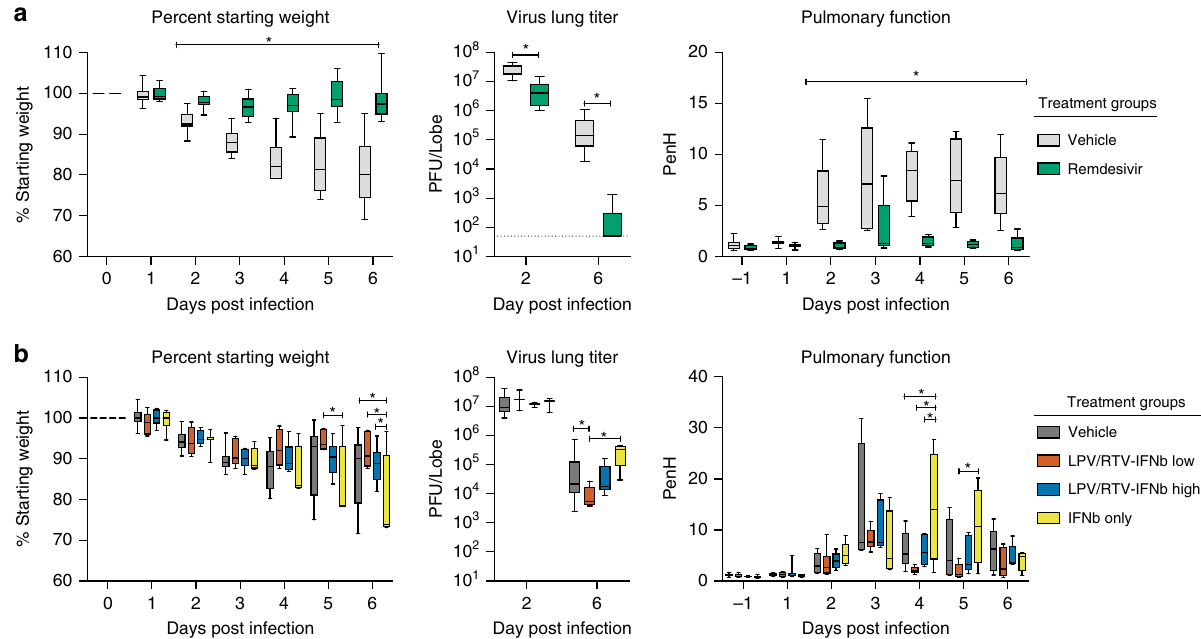
Fig. 4 Prophylactic LPV/RTV + IFNb does not improve disease outcomes. a Percent starting weight (Left) of 12 – 14-week-old female Ces1c − / − hDPP4 mice infected with 5E + 04 pfu MERS M35C4 and treated BID with either vehicle ( n = 9) or remdesivir (RDV, 25 mg/kg, n = 9) subcutaneously beginning − 1 dpi. Asterisks indicate statistically signi fi cant differences ( P < 0.05) as determined by two-way ANOVA and Tukey ’ s multiple comparison test. (Middle) MERS-CoV lung titer on 2 ( N = 3) and 6 dpi (all remaining animals). Asterisks indicate statistically signi fi cant differences ( P < 0.05) as determined by Mann – Whitney test. (Right) WBP was used to assess pulmonary function in mice. PenH is a surrogate measure of airway resistance or bronchoconstriction. Asterisks indicate statistical differences by two-way ANOVA with Sidek ’ s multiple comparison test. b Percent starting weight (left), virus lung titer (middle), and pulmonary function metric PenH (right) of cohorts of mice similar in age and sex and infected similarly with MERS-CoV as in b but treated with vehicle ( n = 9), LPV/RTV + IFNb low (1× human equivalent) ( n = 9), LPV/RTV + IFNb high (25× human equivalent) ( n = 9), or IFNb high only ( n = 9). Oral vehicle or lopinavir/ritonavir (160/40 mg/kg) were administered orally once daily beginning the − 1 dpi. IFNb treatment was initiated 2 h prior to infection and every other day thereafter. To control for dosing effects, vehicle-treated mice received both LPV/RTV vehicle and tests performed on a were performed on b . For the box and whisker plots, the boxes encompass the 25th to 75th percentile, the line is at the median, while the whiskers represent the